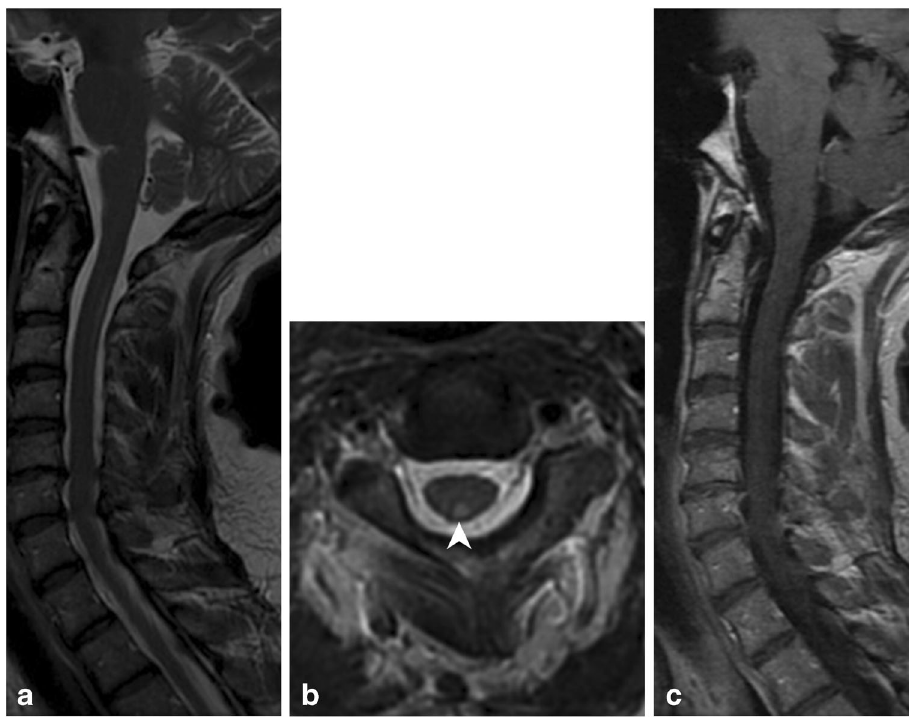
Fig. 10 HIV myelitis. A 54-year- old female with a history of HIV presents with peripheral neuropa- thy. a Sagittal T2-weighted image demonstrates a long segment of hyperintensity in the dorsal cord. b Axial T2-weighted image shows a well-defined dorsal cord lesion (arrowhead) with normal signal within the remainder of the cord. c Sagittal T1 post- contrast image shows no